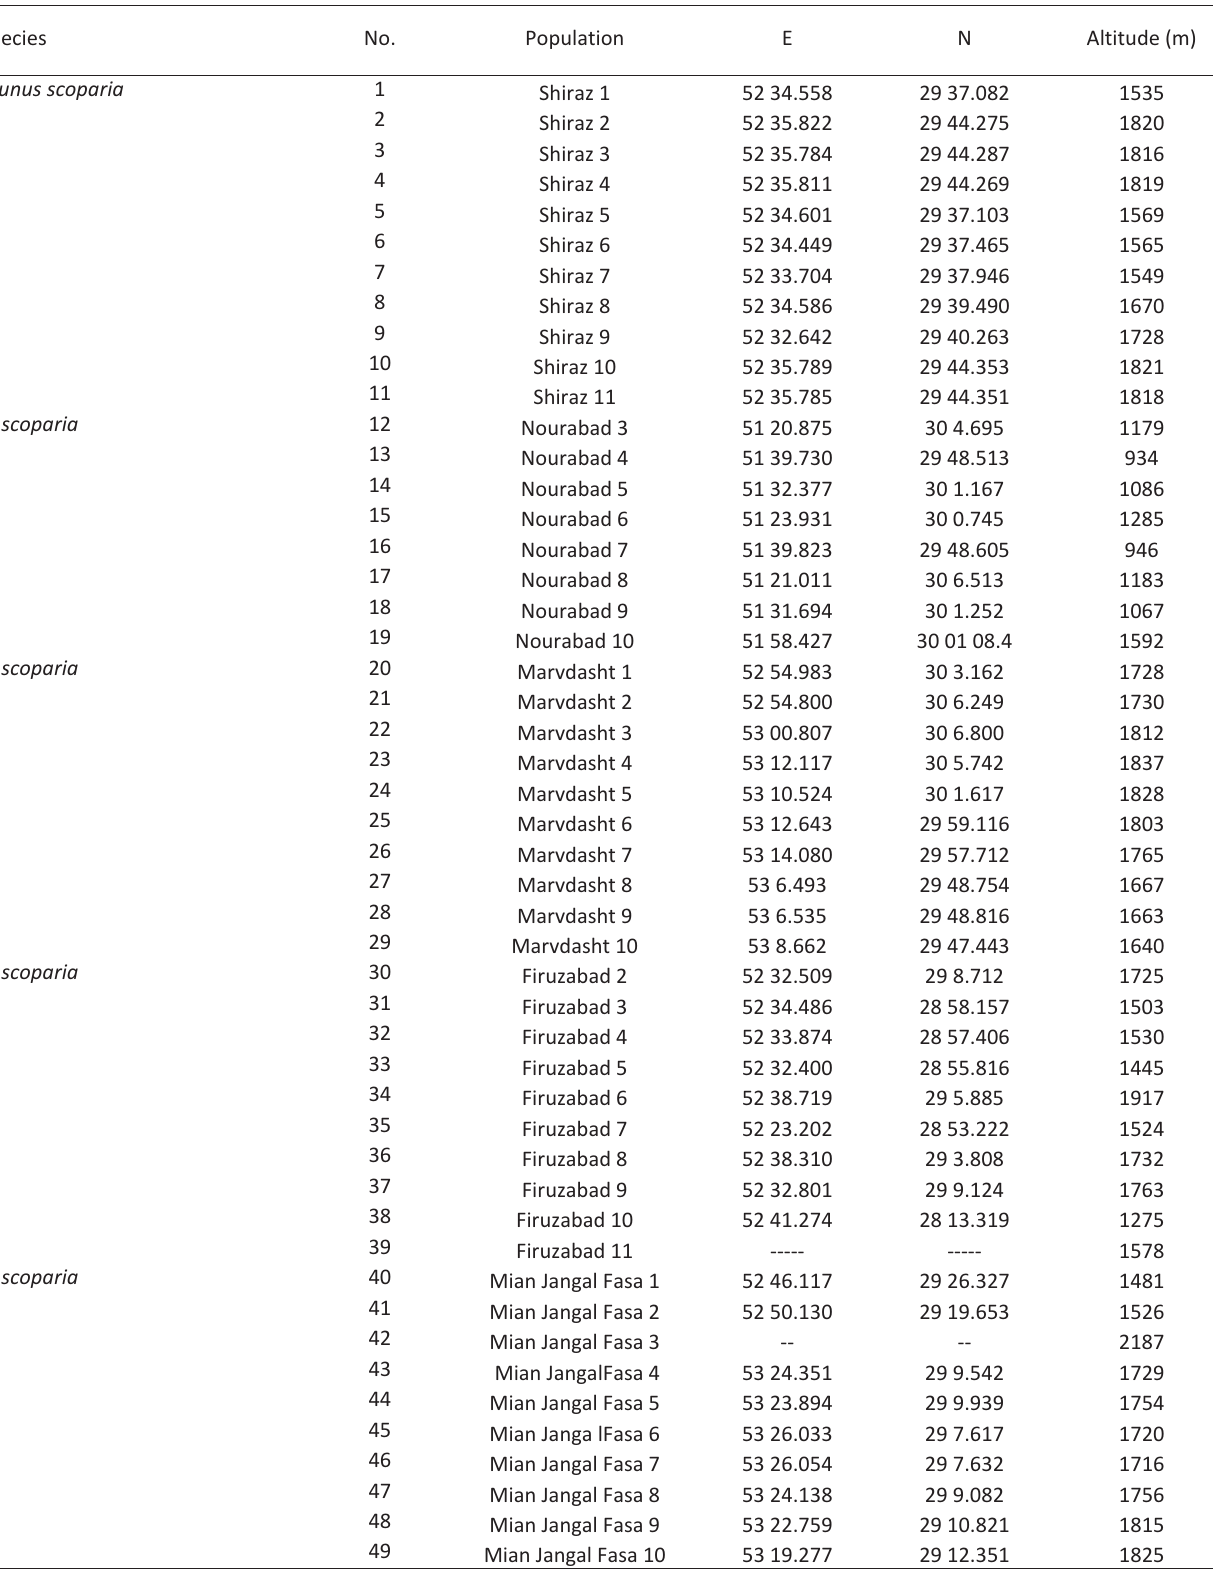
Table 1 ­ List of the studied genotypes with indication of their regions and geographical coordinates of the collection sites Species No. Population E N Altitude (m) Prunus